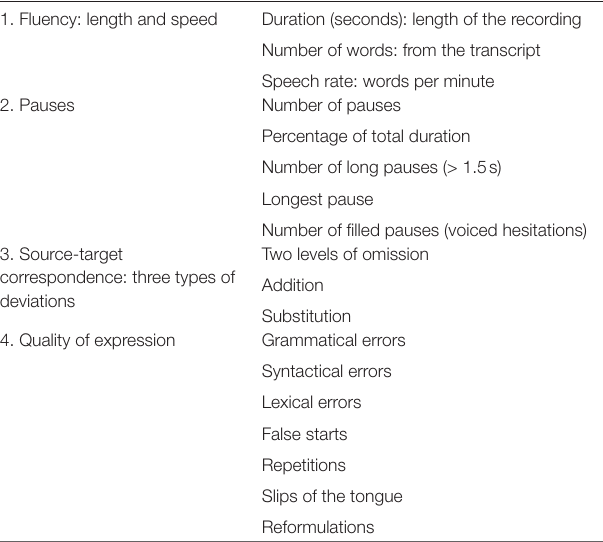
TABLE 2 | Hamidi and Pöchhacker (2007) CI quality